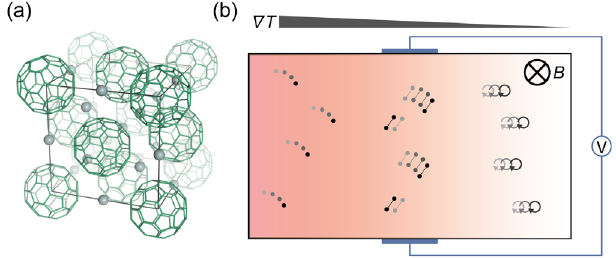
FIG. 1. Probing the Nernst effect in K 3 C 60 . (a) The fcc lattice structure of K 3 C 60 , with potassium atoms shown in gray and carbon buckyballs in green. (b) Schematic of the measurement configuration. A temperature gradient ∇ T is applied orthogonally to the external magnetic field B . The voltage V is then measured orthogonally to both. Cartoons of various possible contributions to the Nernst signal, such as quasiparticles (left), short-lived Cooper pairs (center), and mobile vortices (right), are